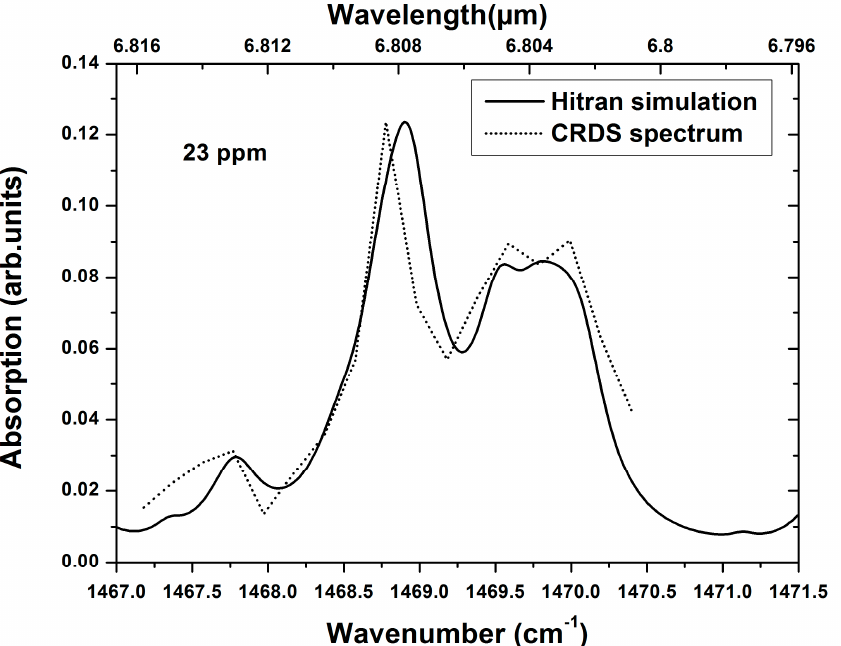
Figure 7. Measured absorption spectrum for 23 ppm of ammonia at a pressure of 0.4 Atmosphere and a temperature of 296 K compared to the HITRAN simulation obtained under the same experimental conditions.